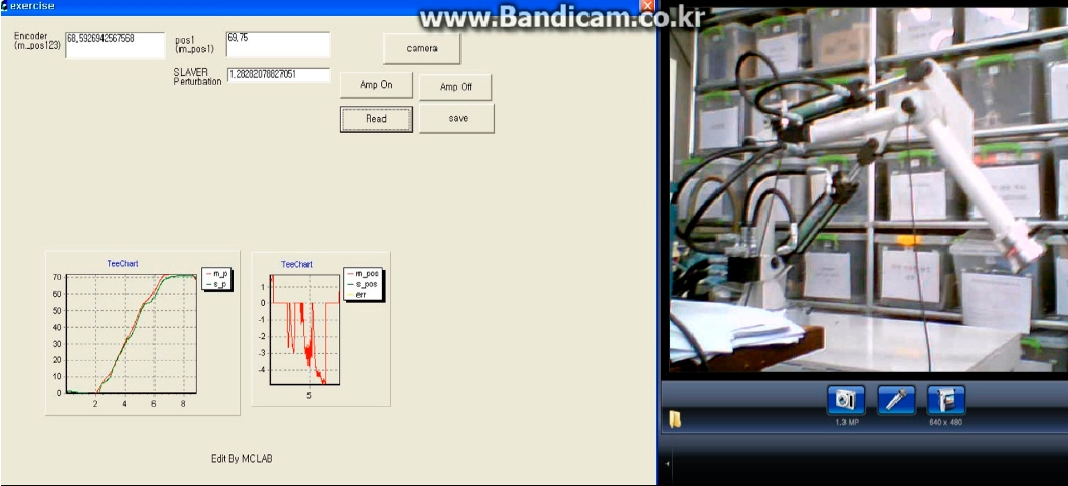
Figure 9. Pictorial view of visual feedback.